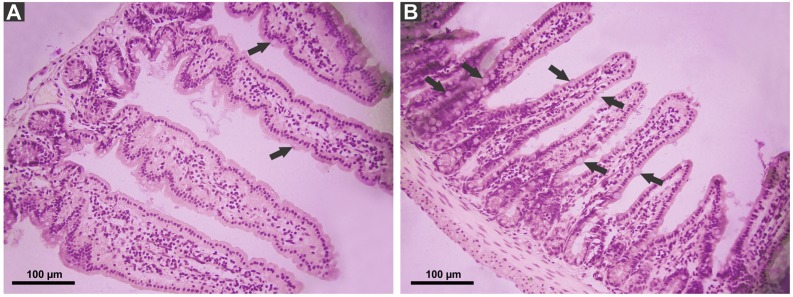
Effect of P. canaliculata PVF on goble cells.Mice were fed on a diet without (A) or with PVF (B) (four doses of 0.56 mg protein each) (B). Arrows indicate goblet cell. Bar 100 µm.